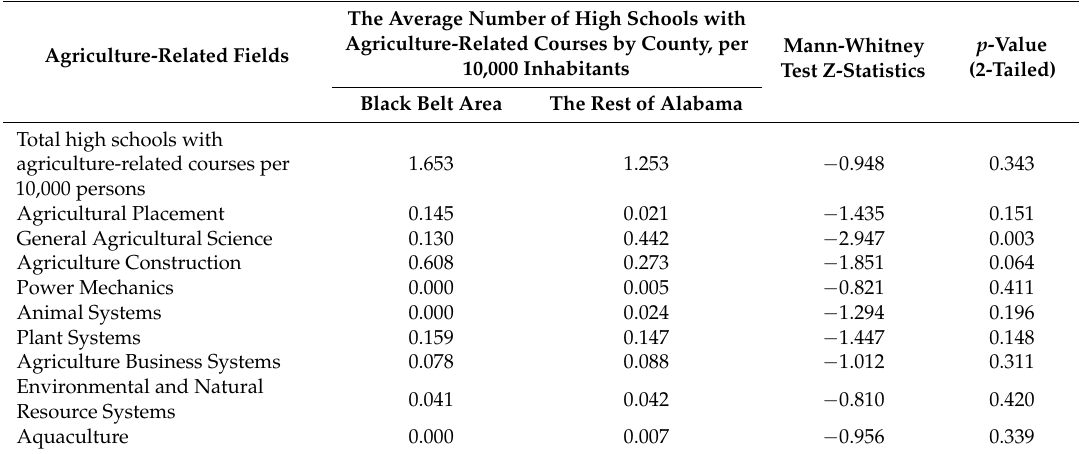
Table 1. Agriculture-related courses in Alabama’s Black Belt area, compared with the rest of the State.